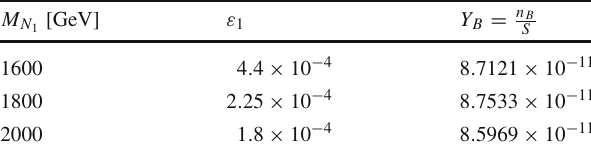
Table 2 Baryon asymmetry of the Universe generated for three differ- and ε 1 ent values of M N 1